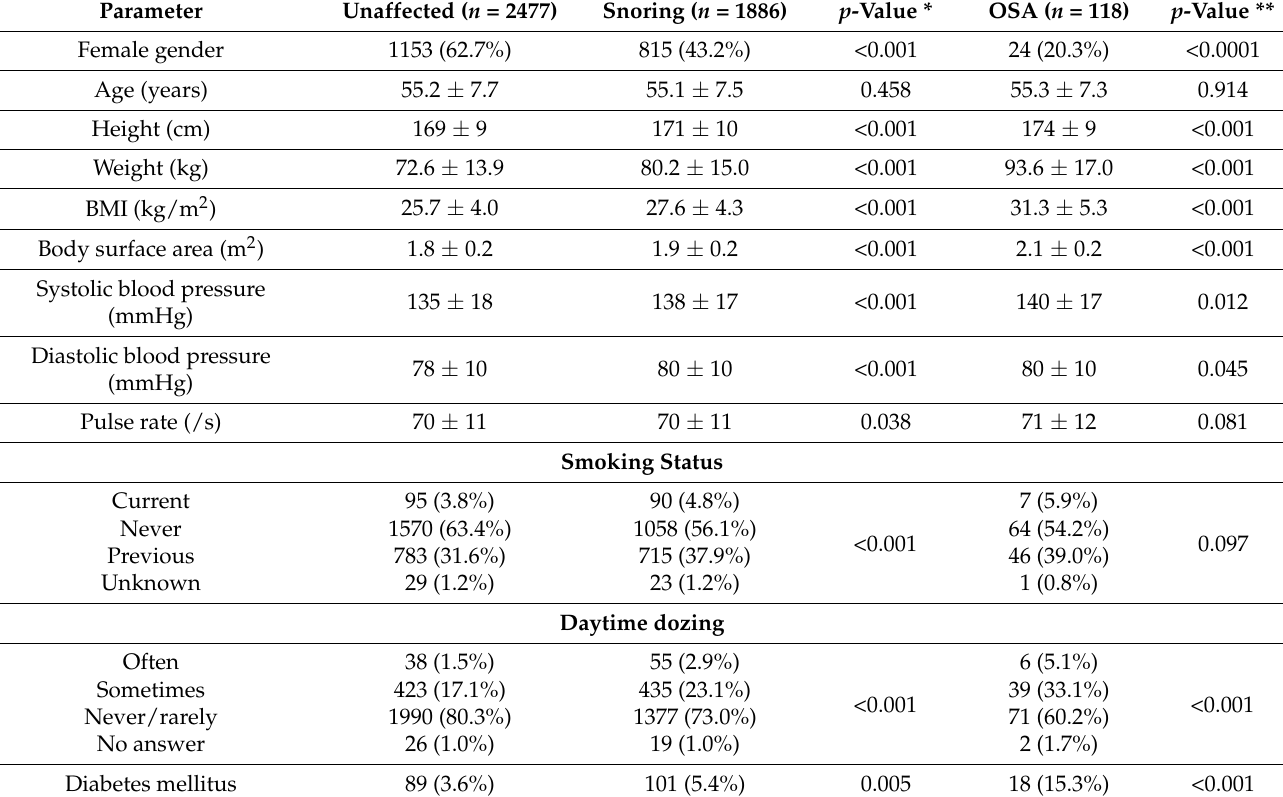
Table 1. Study participant information; snoring vs. unaffected * and OSA vs. unaffected